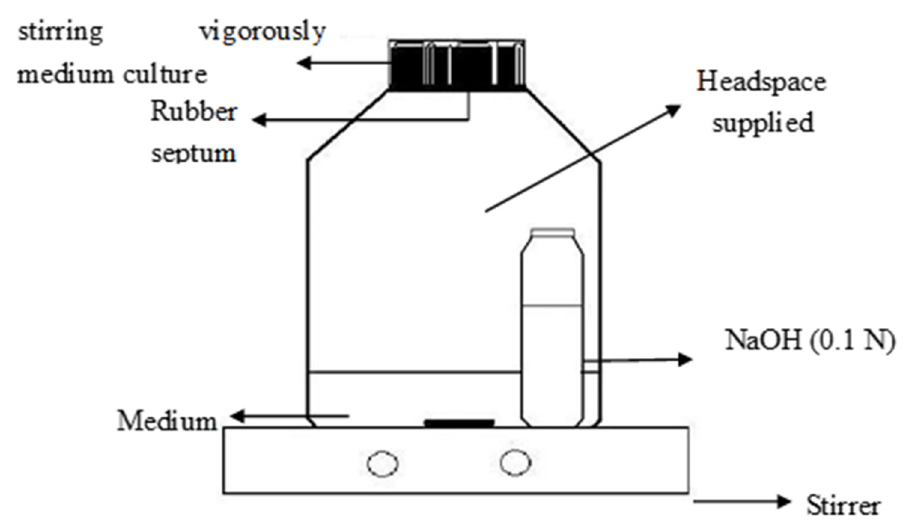
Figure 1. Experimental diagram of mineralization